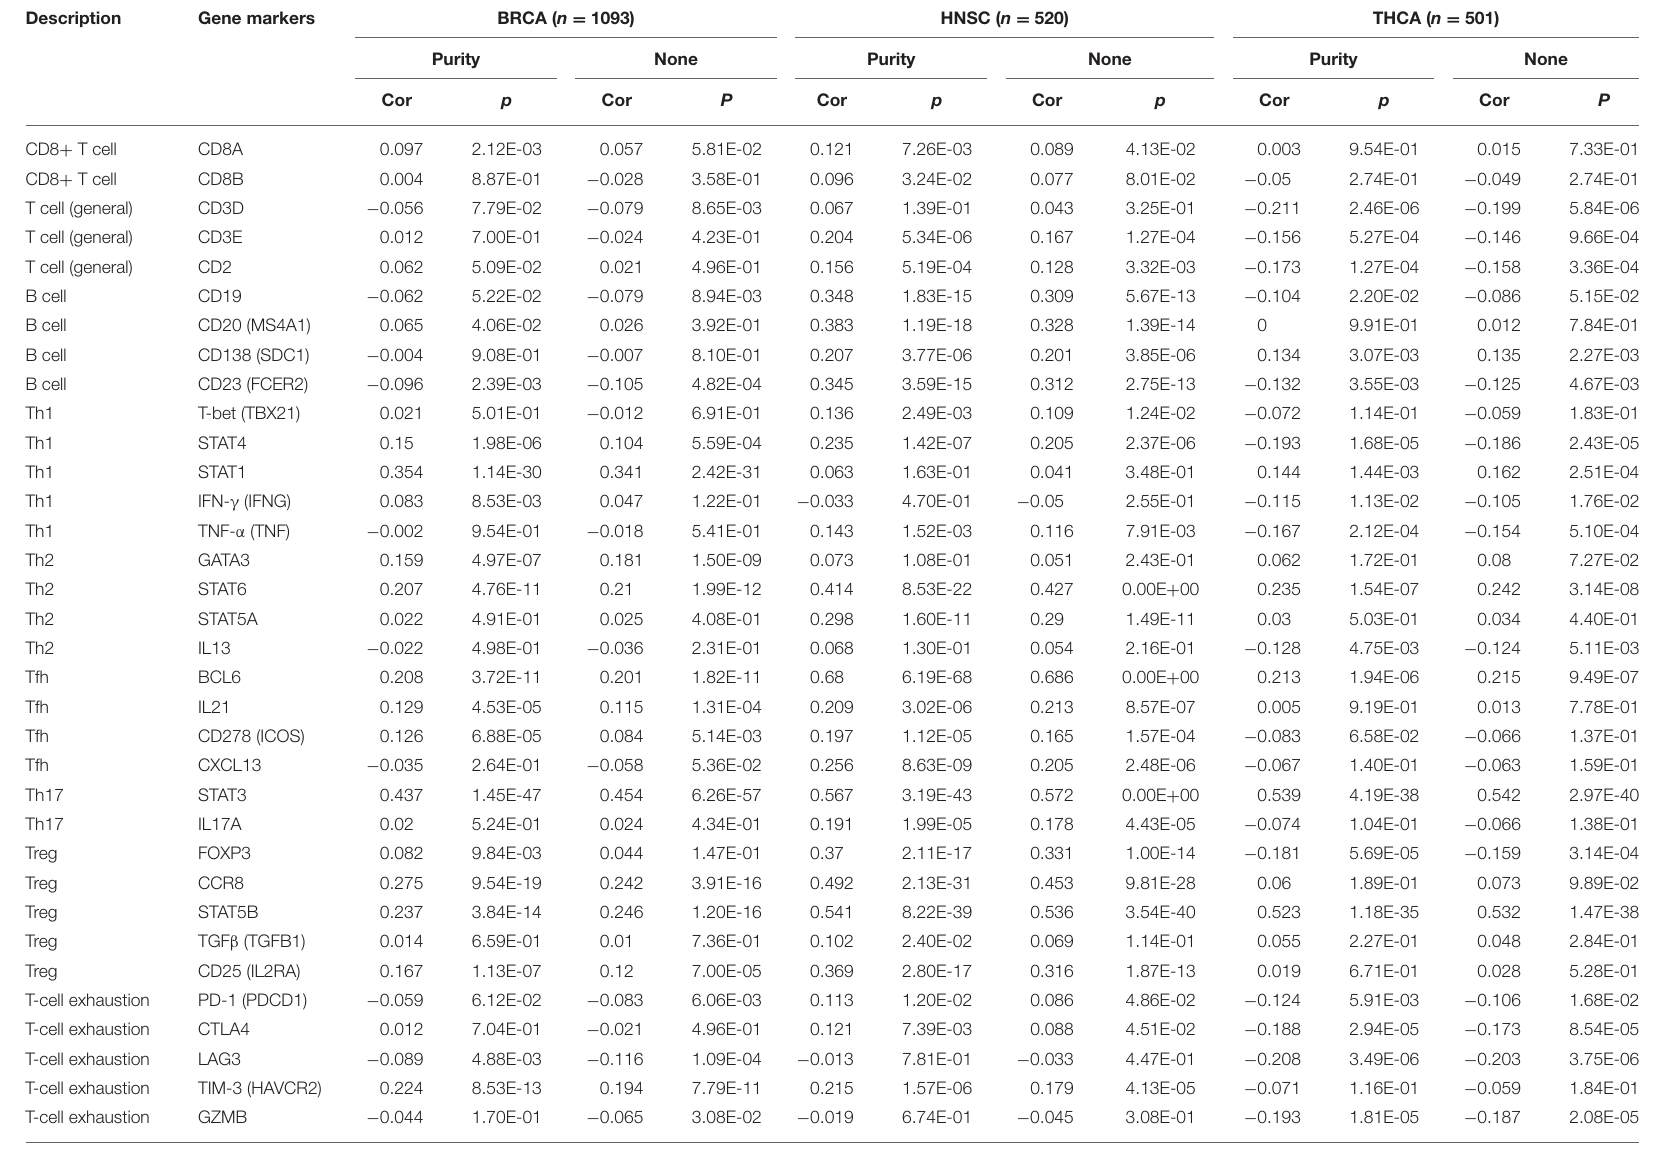
TABLE 3 | Correlation analysis between PERK and related gene markers of adaptive immune cells in TIMER in BRCA, HNSC, and THCA.